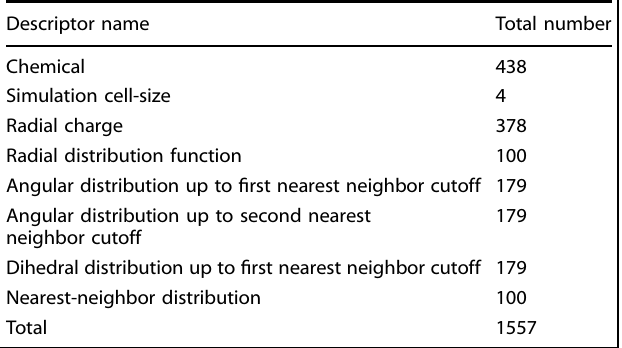
Table 1. Components of classical force- fi eld inspired descriptors (CFID) 47